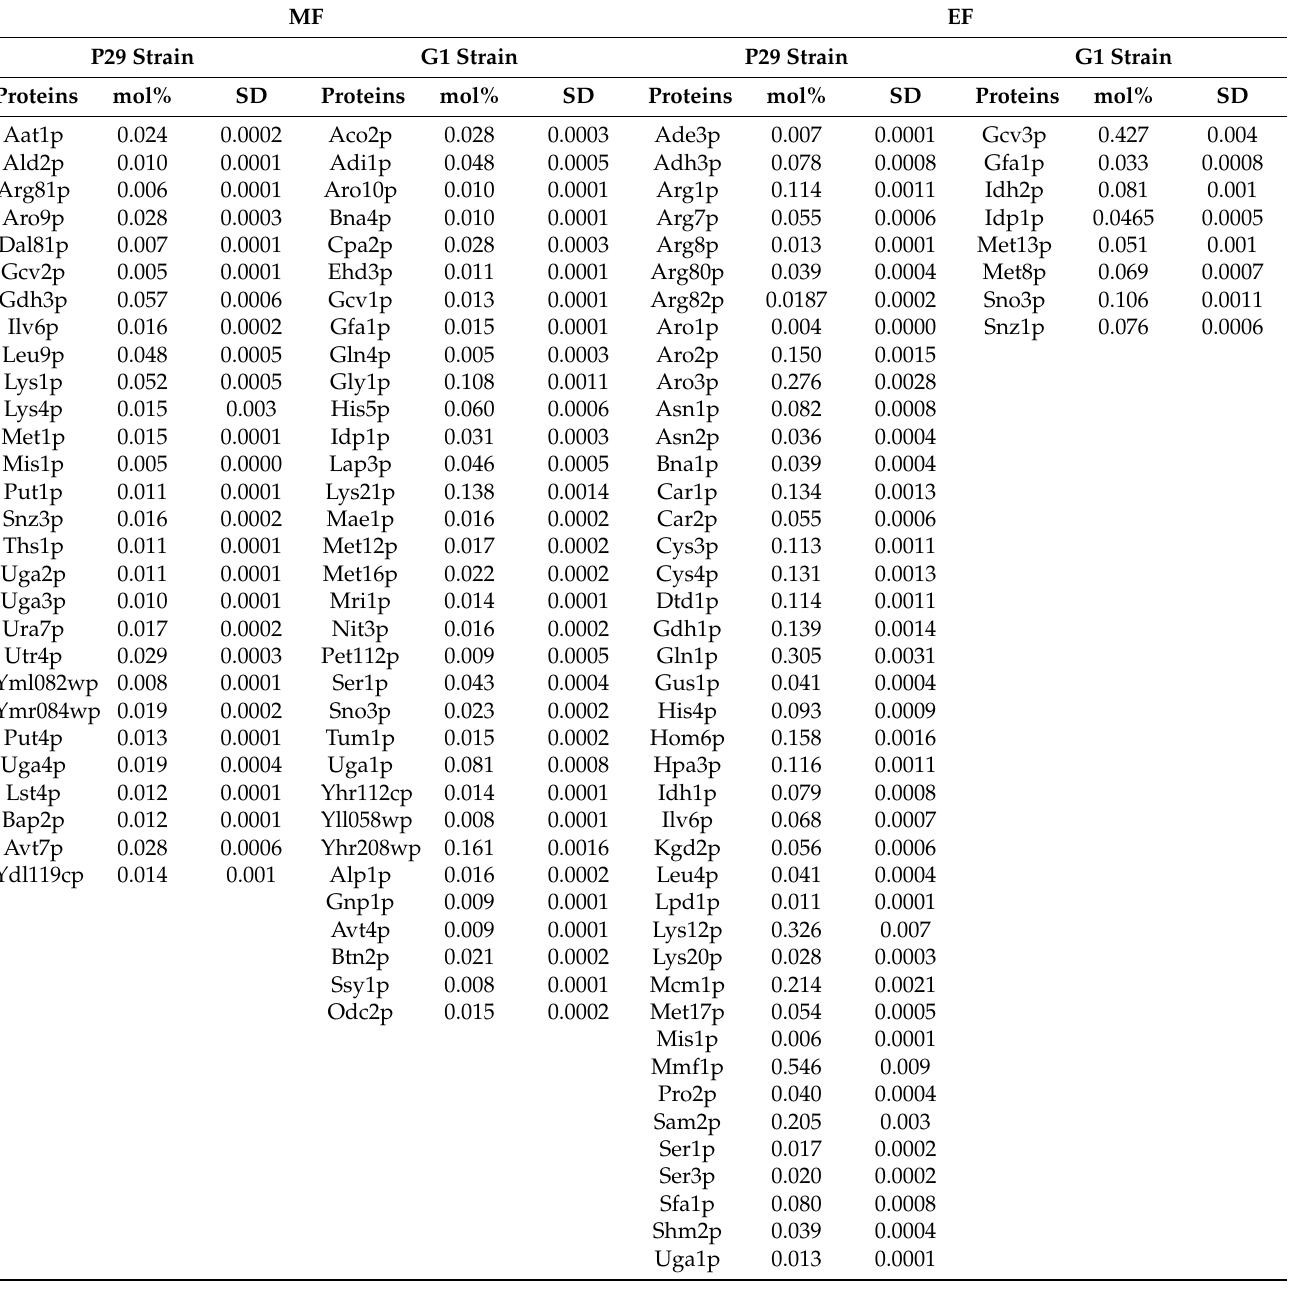
Table 2. Quantification of specific proteins identified in each strain using the EmPAI method (mol%) in S. cerevisiae P29 and G1 during two sampling times: at the middle of the second fermentation (MF) and at the end of the second fermentation